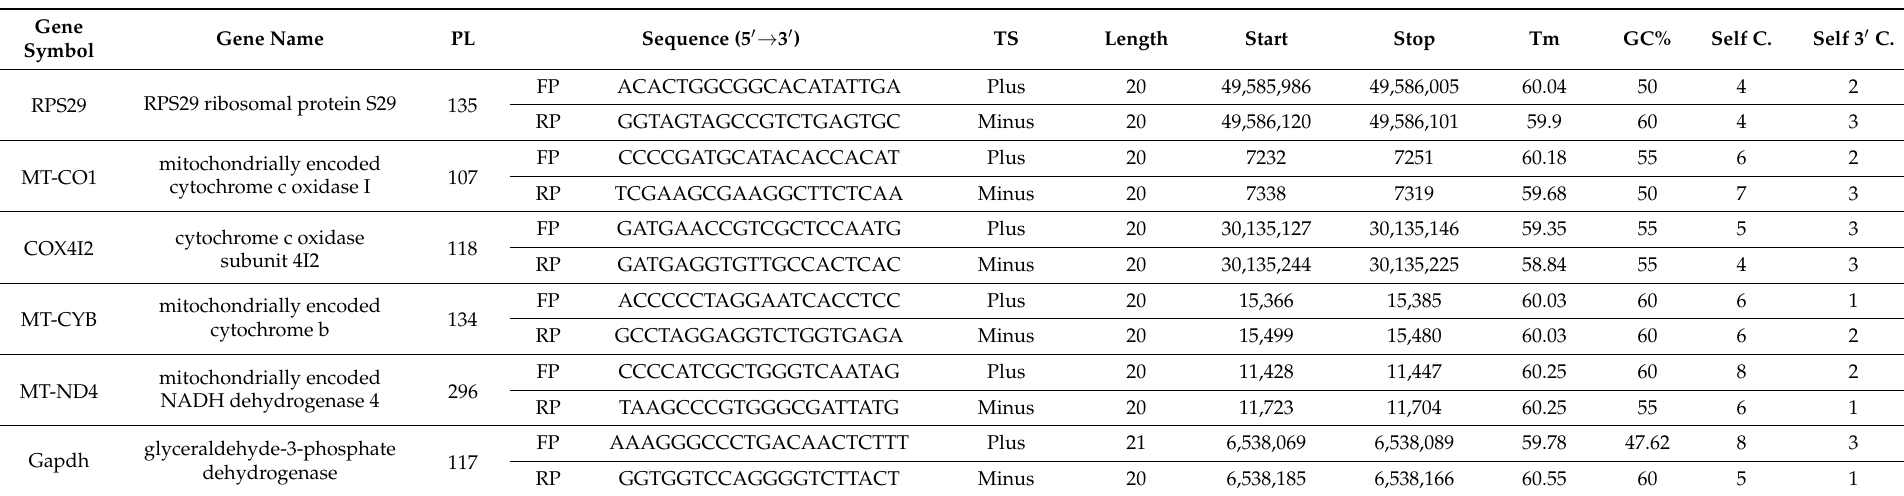
Table 1. Genes selected for qRT-PCR analysis. Primer sequences and associated parameters are